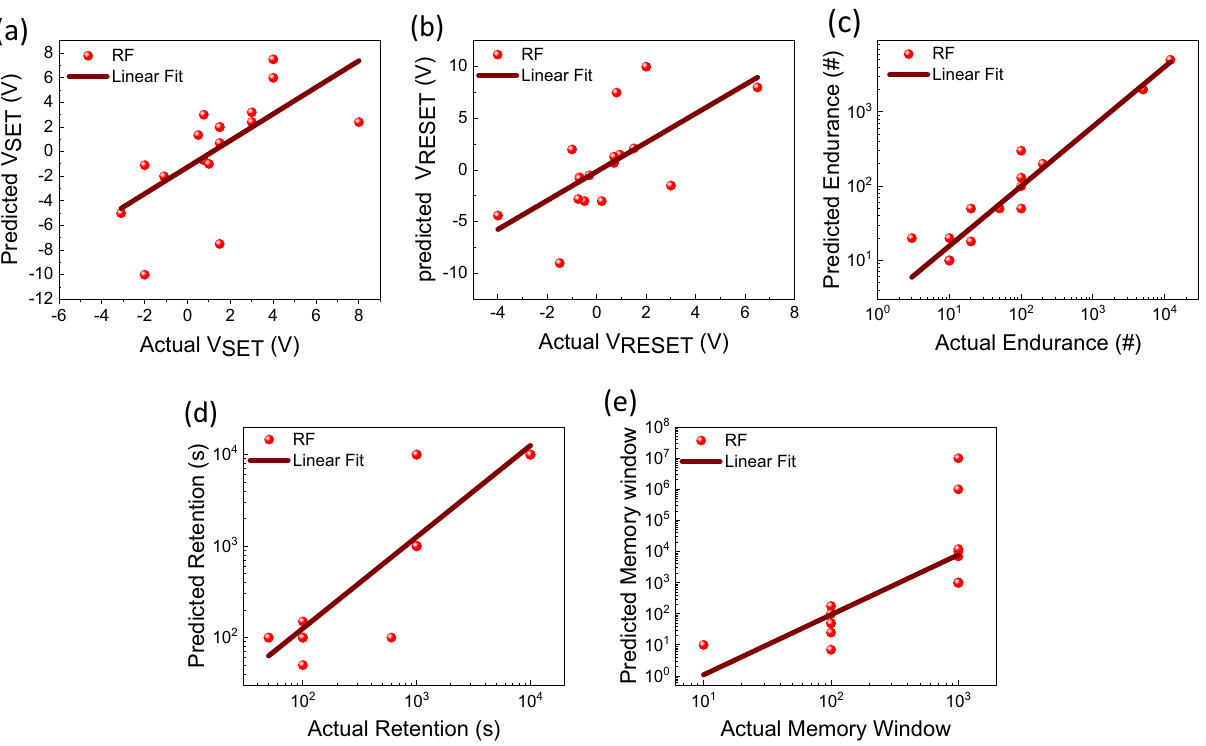
Figure 6. RF-based predictions of output performance features of the copper oxide-based RS devices. Predictions of ( a ) V SET , ( b ) V RESET , ( c ) endurance, ( d ) retention, and ( e ) memory window. The data are fitted by a linear fitting